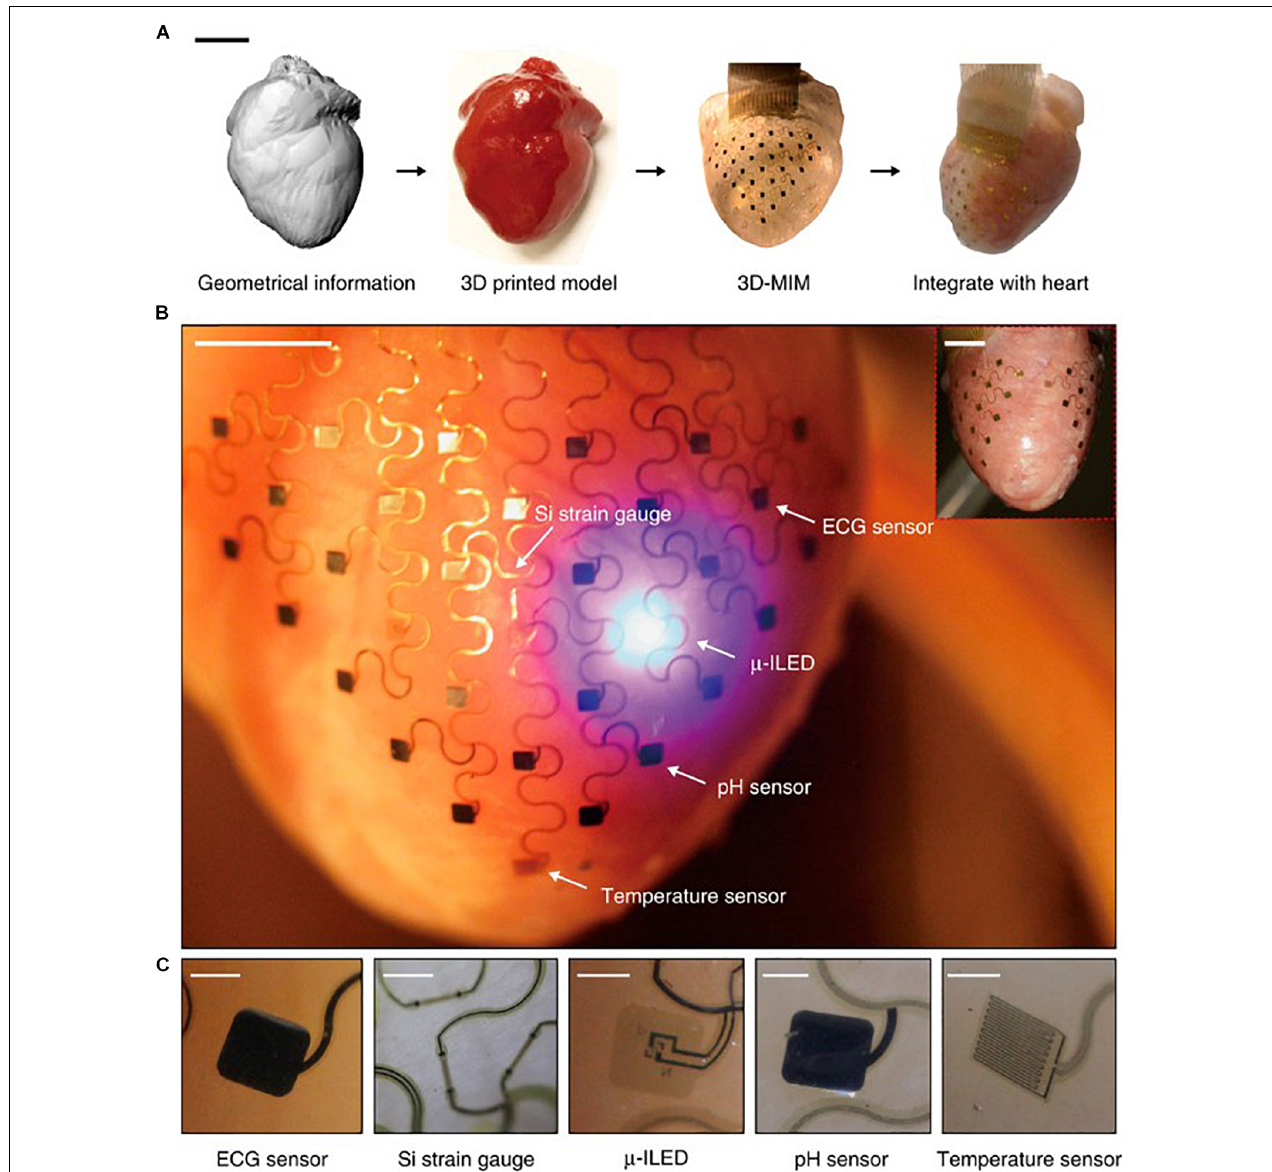
FIGURE 1 | Pericardium-inspired conformal three-dimensional multifunctional integumentary membrane (3D-MIM) for optical stimulation. (A) The 3D-MIM substrate is created by capturing the 3D geometry of the heart, rendering a solid model, and casting and curing a thin silicone elastomer. Scale bar, 2 cm. (B) A representative image of the 3D-MIM deployed on a Langendorff-perfused rabbit heart with u-ILEDs, pH sensors, and temperature sensors that cover both the anterior and posterior sides of the heart. Scale bar, 6 mm. (C) Detailed view of each type of sensor that is integrated into the 3D-MIM. Scale bars, 500 um. Reproduced from Xu et al.